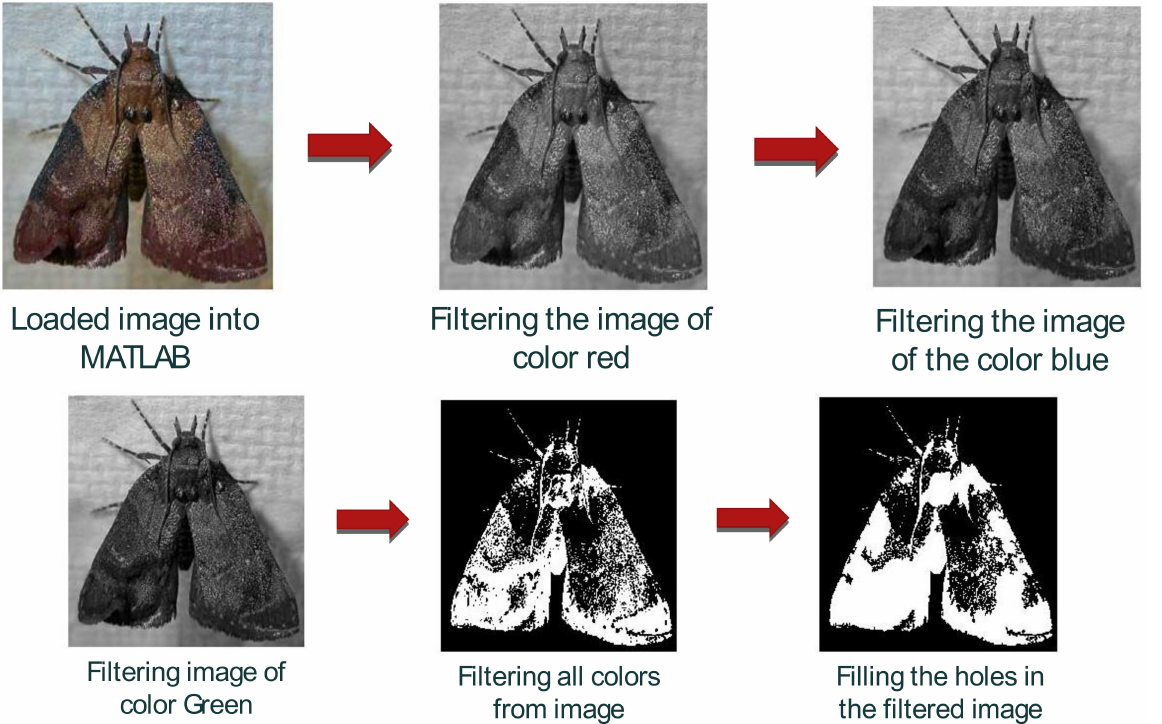
Figure 13. The process associated with detected pest with image